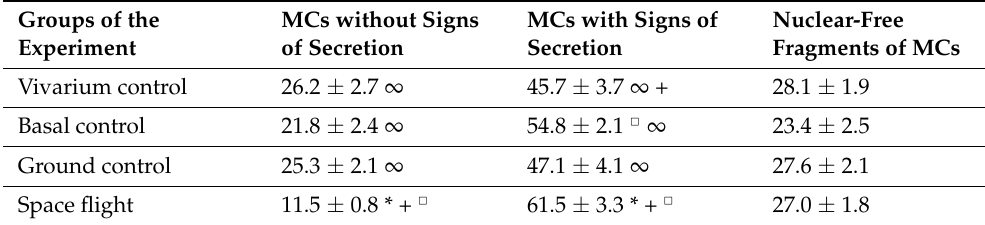
Table 2. Secretory activity of the skin MC population in mice, % (Technique: staining with Giemsa